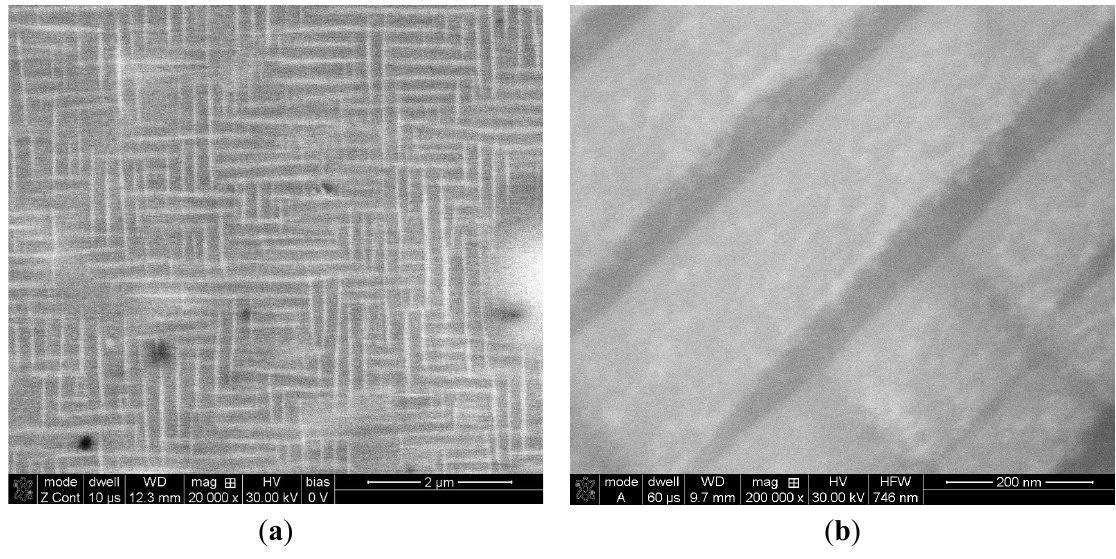
Figure 7. ( a ) SEM BSE image showing the coherent two-phase microstructure of sample no. 1 after annealing; ( b ) STEM image taken from a lamella that was cut from the